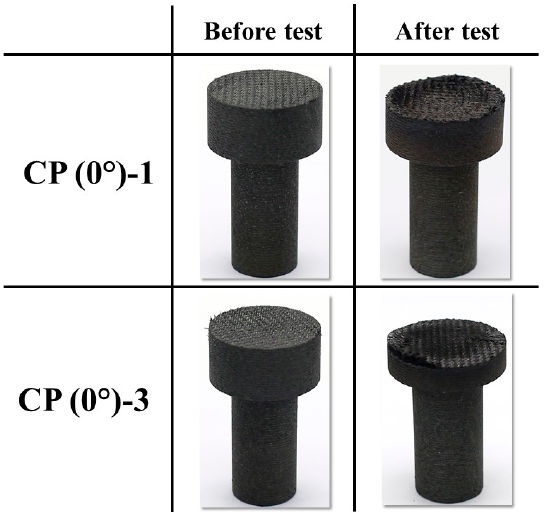
Figure 9. CP (0°)-1 (3.25 MW/m 2 , 60 s) and CP (0°)-3 (6 MW/m 2 , 30 s) before and after test images. Figure 9. CP (0 ◦ )-1 (3.25 MW/m 2 , 60 s) and CP (0 ◦ )-3 (6 MW/m 2 , 30 s) before and after test